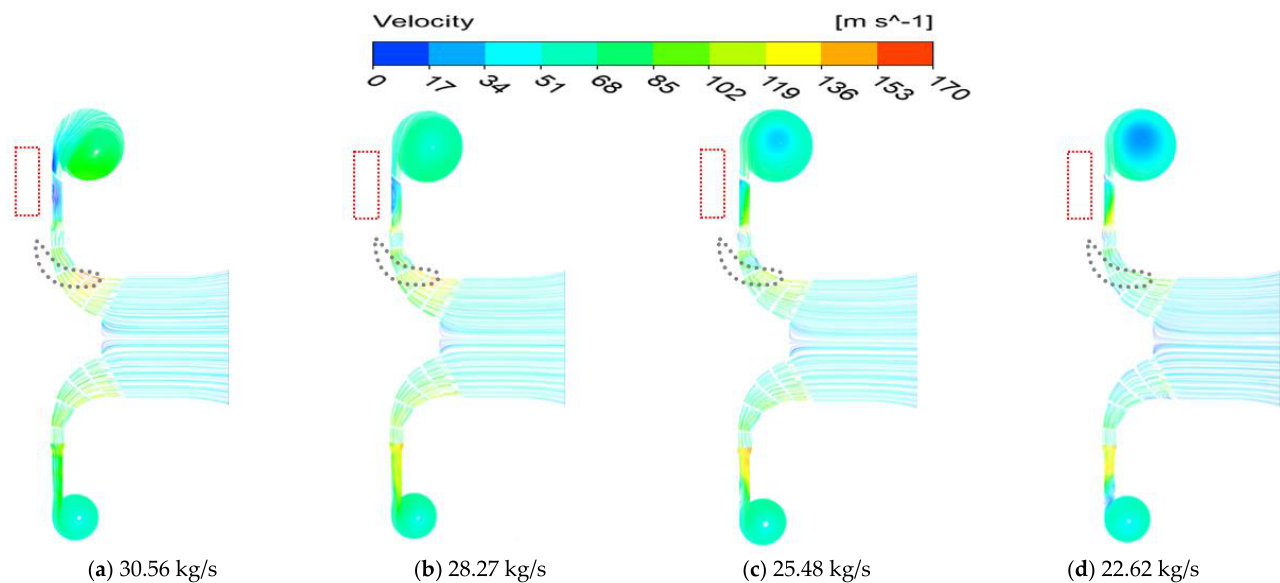
Figure 4. Streamline for different mass-flow rates in x = 0mm section.